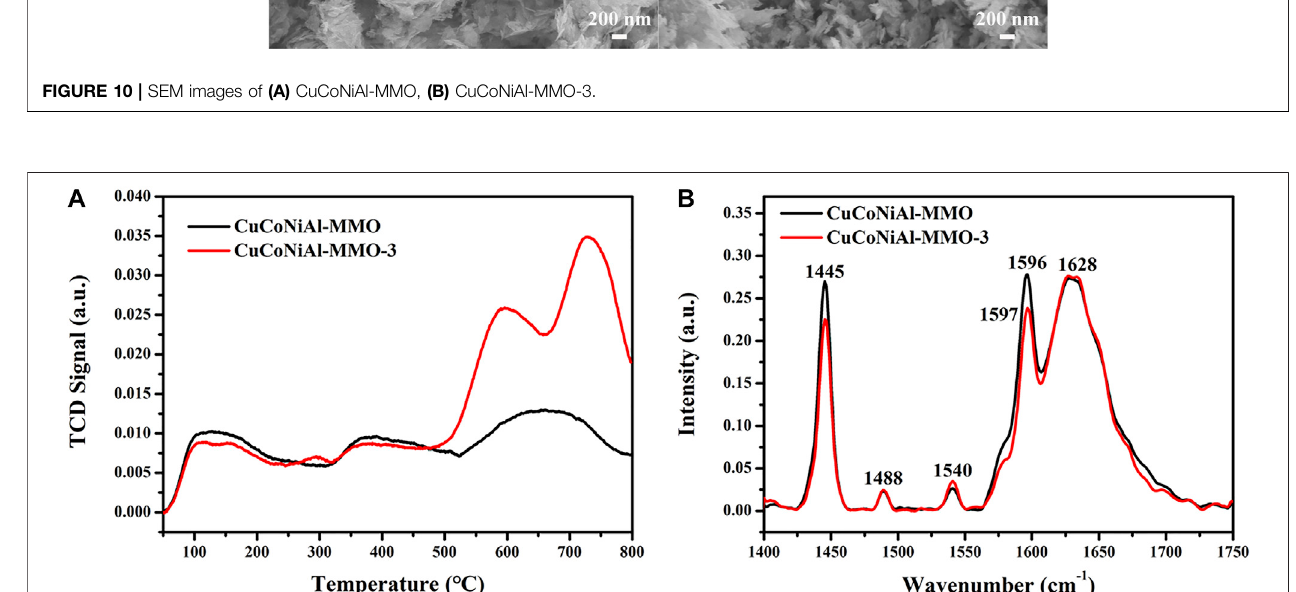
FIGURE 11 | Characterization of surface acidity of the different catalysts. (A) NH 3 -TPD (B) Py-IR spectra for CuCoNiAl-MMO and CuCoNiAl-MMO-3.